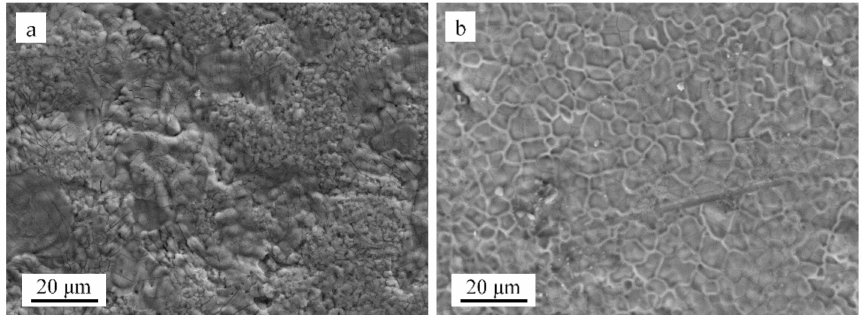
Figure 2. Surface SEM photographs of two alloys oxidized in air at 1200 ◦ C for 100 h: ( a ) Fe-Cr-Al alloy and ( b ) Fe-Cr-Al–ODS alloy.